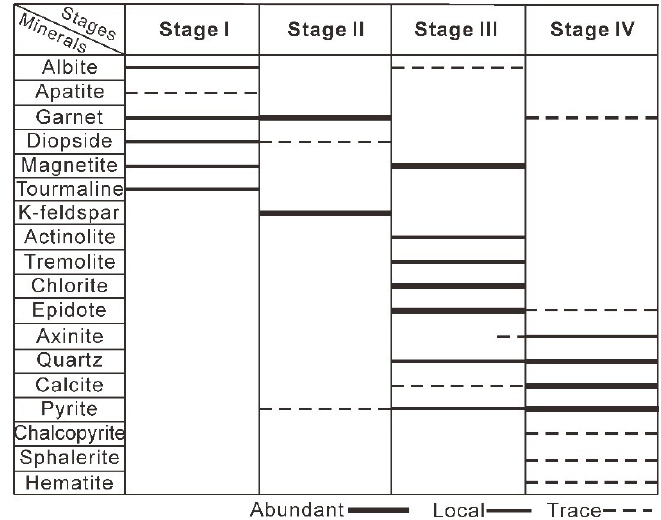
Figure 3. Alteration and mineralization paragenesis of the Yamansu iron deposit.